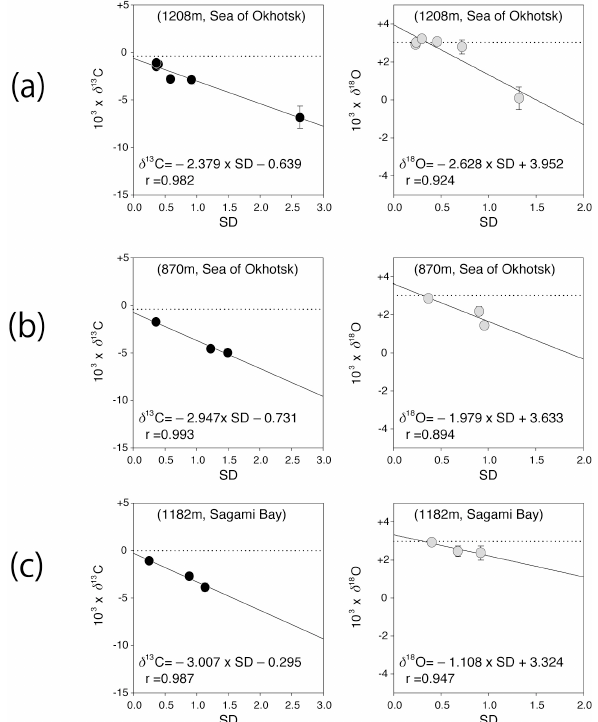
Fig. 6. Relationships between average δ 13 C and δ 18 O values and inter-individual variations (SD; standard deviation) for each species of benthic foraminifera analyzed. (a) Sea of Okhotsk, 1208m bot- tom depth; (b) Sea of Okhotsk, 870m; (c) Sagami Bay, 1182m. Solid lines and equations are linear regression results. Dotted lines represent δ 13 C DIC and δ 18 O e.c. at each site. Error bars indicate the range of standard error for each